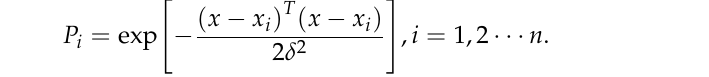
Figure 10. Schematic diagram of GRNN structure. The number of nodes in the GRNN input layer is equal to the dimension of input vectors in learning samples, and the number of nodes in the hidden layer is equal to the number n of learning samples. The output of input layer node i is in exponential form of exponential square D i 2 = ( x − x i ) T ( x − x i ) of Euclid distance square between input variable and its corresponding sample x . The hidden layer function is: